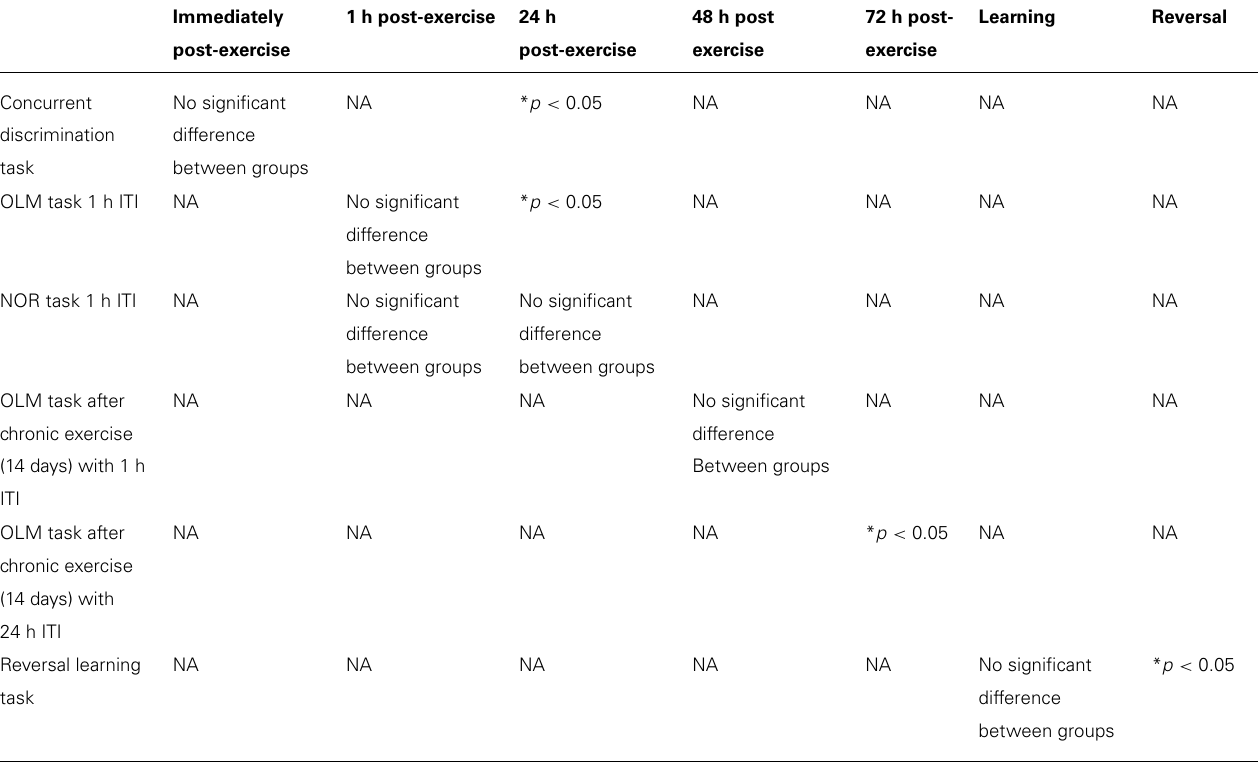
Table 1 |The effect of exercise on different behavioral